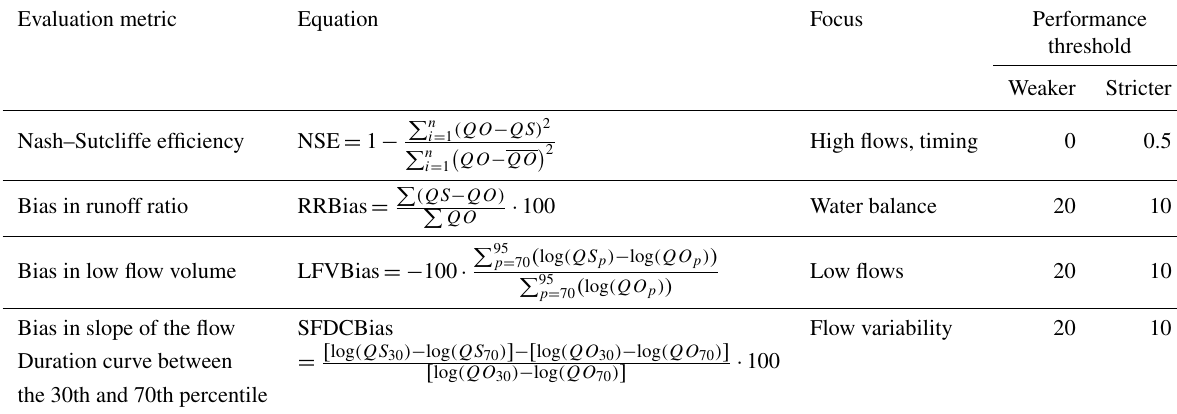
Table 3. Evaluation metrics used in the study. Evaluation metric Equation Focus Performance